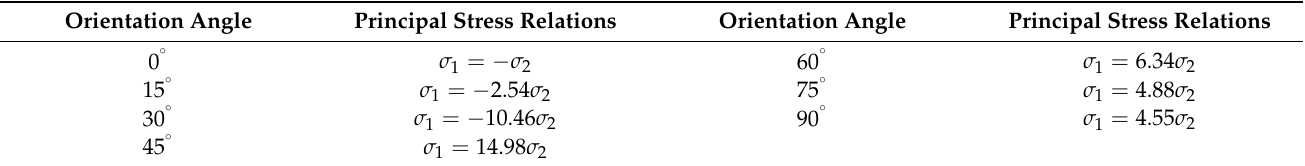
Table 1. Relations between the principal stresses for the orientations of the Arcan device.